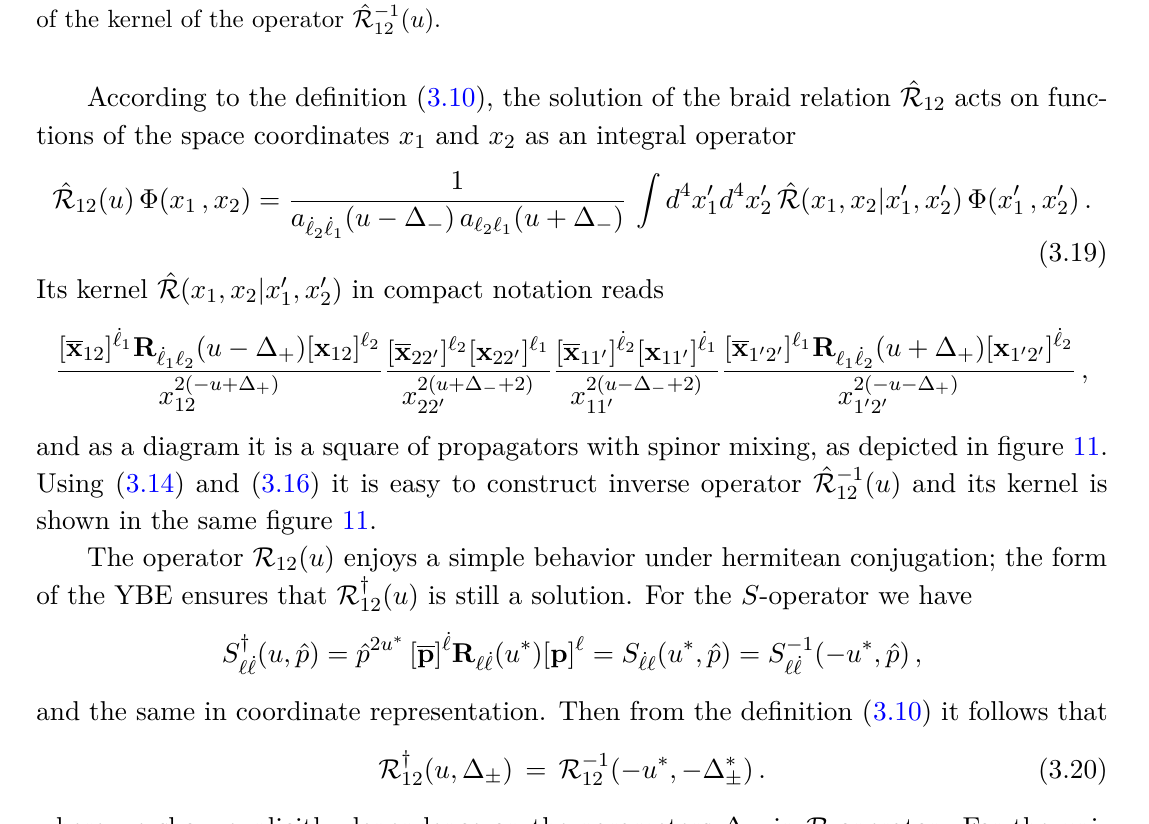
Figure 11 . Left: diagram of the kernel of each segment are the powers of the inverse square distance between the end points. Grey solid lines represent the fused SU(2) R-matrix acting along the spinorial structure of the propagators. The argument of matrices R are the opposite of the power of the adjancent line. Right: diagram of the kernel of the operator ˆ R − 1